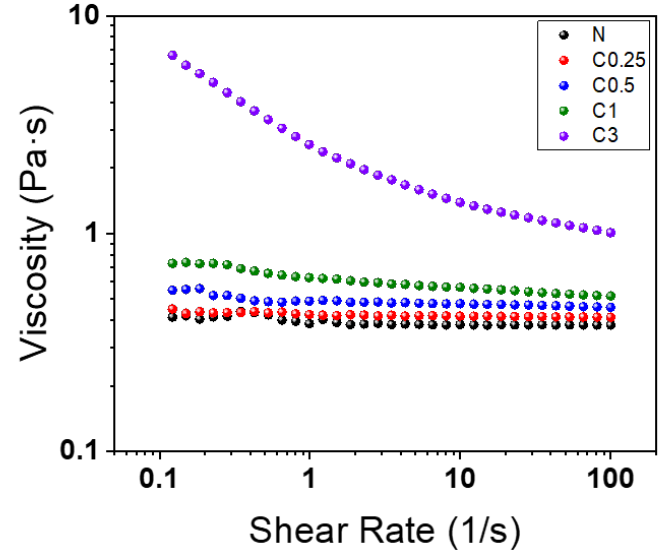
Figure 3. Rheometer curves of polyol and polyols after mixing with CNF.